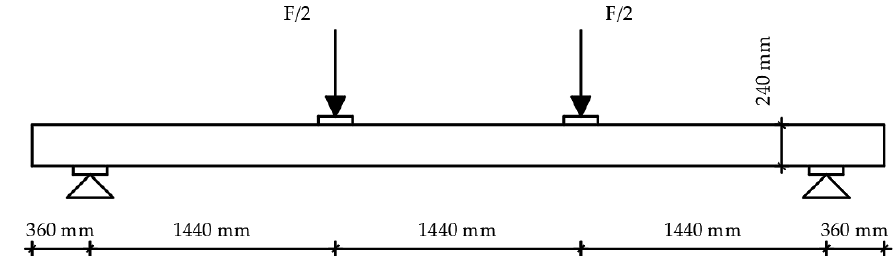
Figure 11. Strong-axis bending experimental test setup.